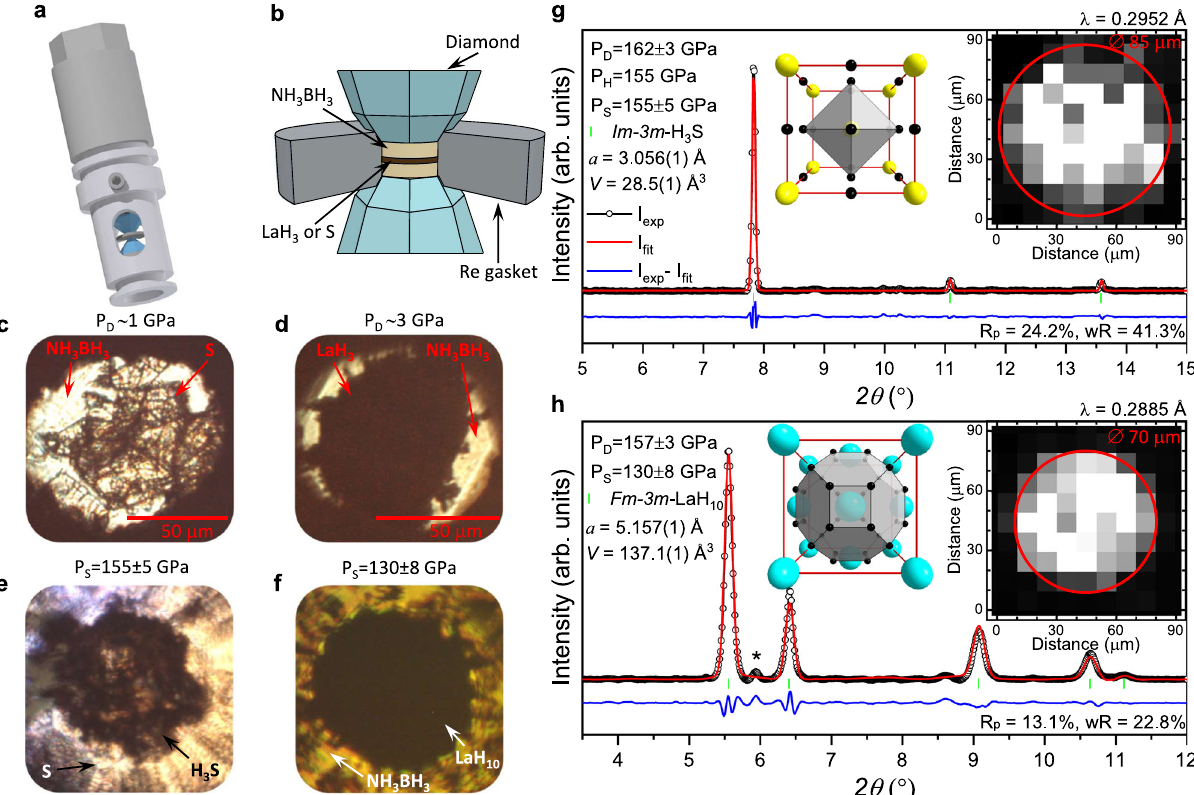
Fig. 1 Synthesis of the Im-3m -H 3 S and Fm-3m -LaH 10 phases. a Illustration of the miniature DAC used for magnetic measurements in SQUID. b Scheme showing the typical arrangement of the sandwiched precursors in the DAC. c , d Photos of the sandwiched samples, S + NH 3 BH 3 and LaH 3 + NH 3 BH 3 , after loading at P D ∼ 1 and ∼ 3 GPa, respectively. e , f Photos of the H 3 S and LaH 10 samples after compression and subsequent pulsed laser heating. g , h X-ray powder diffraction patterns collected from the synthesized Im-3m -H 3 S and Fm-3m -LaH 10 samples. The black circles and red and blue curves correspond to the experimental data, Rietveld re fi nement fi ts and residues, respectively. The green ticks indicate the calculated peak positions. The (101) re fl ection stemming from the P6 3 /mmc -LaH 10 impurity phase is marked by asterisk. The fragments of the crystal structure with the characteristic SH 6 and LaH 32 coordination polyhedra are shown as insets. The large yellow and cyan and small black spheres represent the S, La and H atoms in the crystallographic unit cells, respectively. The spatial distribution across the heated samples and the estimated diameter of the superconducting Im-3m -H 3 S and Fm-3m -LaH 10 phases are shown as inset. P D , P H and P S are pressure values estimated from the position of diamond edge and hydrogen vibron in Raman spectra and re fi ned lattice parameters of the fi nal products, respectively (see details in “ Methods ”